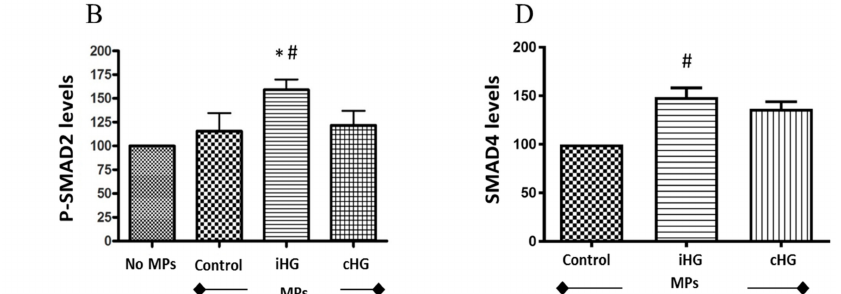
Figure5. Highglucose-derivedmicroparticles(MPs; 10 µ g / mL)activatetransforminggrowthfactor-beta (TGF- β ) pathway via phosphorylation of SMAD2 and nuclear translocation of SMAD4 in naïve renal proximal tubular cells. ( A ) Representative Western blot of phosphorylated SMAD2; ( B ) densitometry analysis of P-SMAD2 levels normalized to β -actin; ( C ) representative Western blot of SMAD4 in the nuclear fraction; and ( D ) densitometry analysis of SMAD4 levels normalized to Lamin-B. * p < 0.05 versus no MPs (control); # p < 0.05 versus control MPs; P-SMAD2: Phosphorylated-SMAD2; iHG: Intermittent high glucose; cHG: Continuous high glucose.